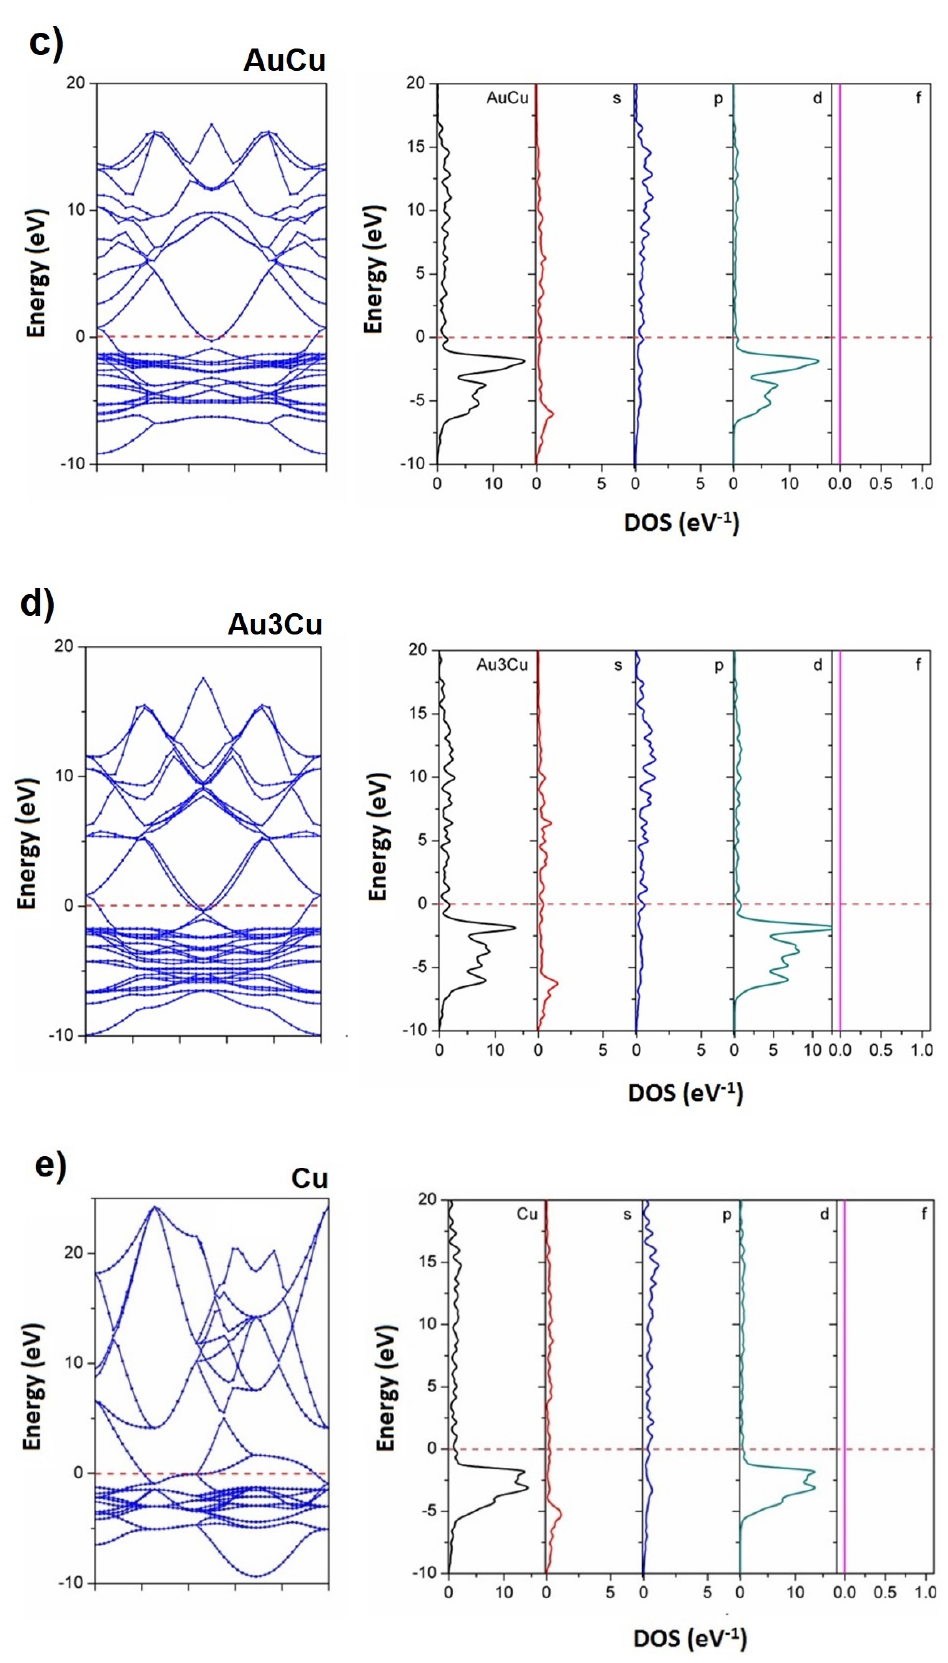
Figure 4. PDOSs and electronic structures of Au ( a ), Au3Cu ( b ), AuCu ( c ), AuCu3 ( d ), and Cu ( e ) were calculated using